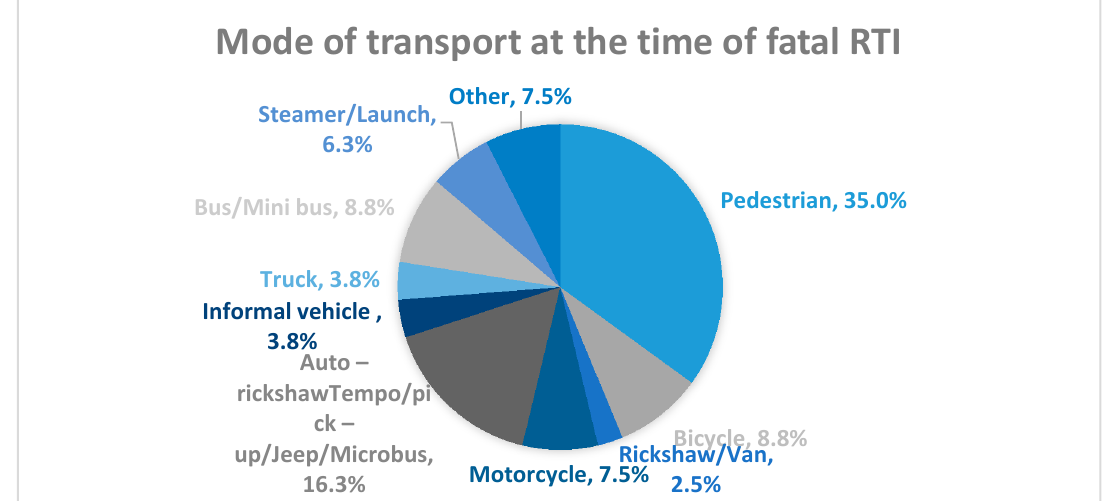
Figure 2. Mode of transport at the time of fatal RTI.